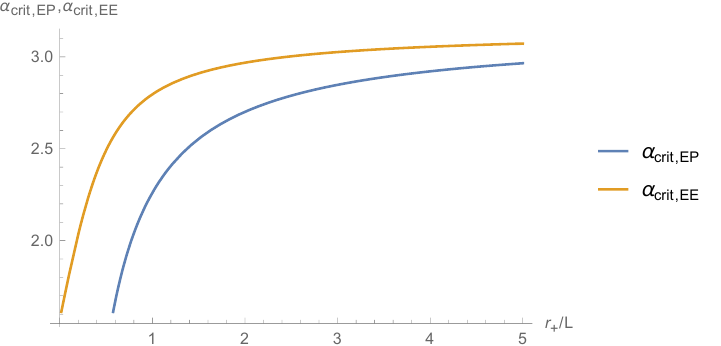
Figure 7. The two critical angles (cid:11) crit;EE and (cid:11) crit;EP versus r + =L AdS . Only the range r + =L AdS > 1 is physically